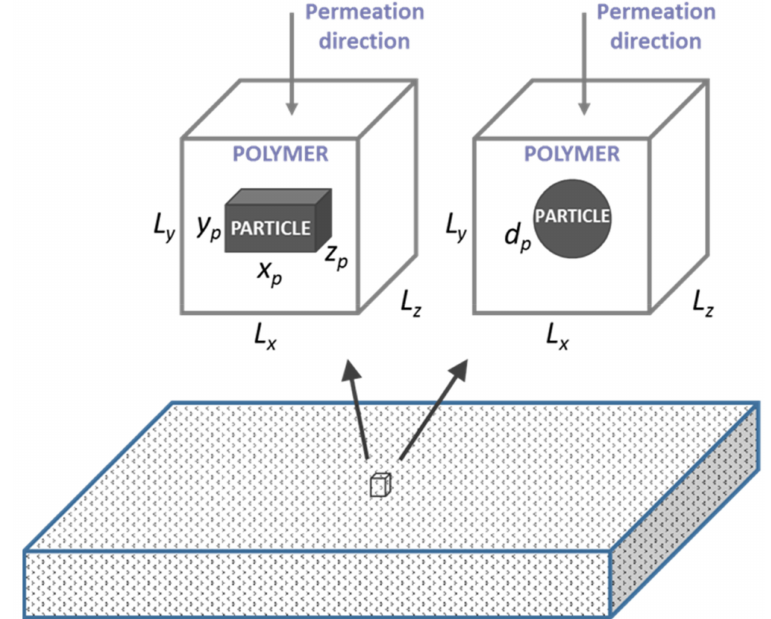
Figure 1. Schematic diagram of a MMM and one elementary unit with a nanoparticle located at its center; y is the direction of the gas permeation. The dimensions of the cuboid nanoparticle are x p , y p , and z p , and the spherical particle is d p . The dimensions of the polymer elementary unit are L x , L y , and L z